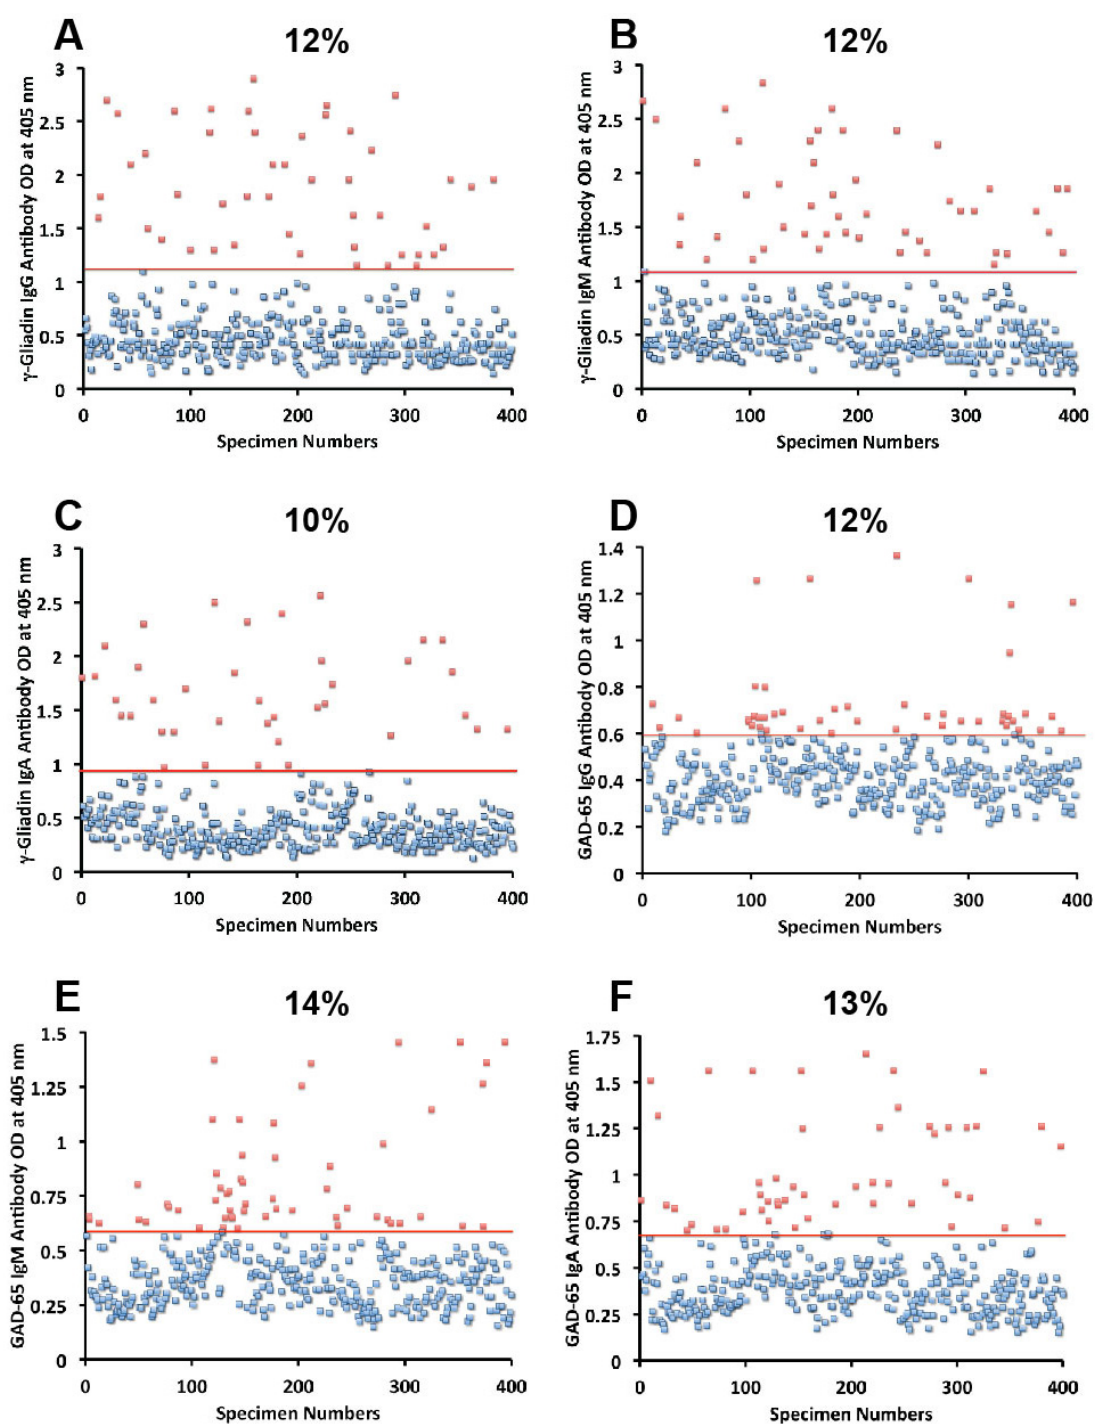
Figure 2. Results for γ -gliadin and GAD-65 expressed as OD at 405 nm in the form of scattergrams with percentages of elevation. ( A ) γ -gliadin IgG; ( B ) γ -gliadin IgM; ( C ) γ -gliadin IgA; ( D ) GAD-65 IgG; ( E ) GAD-65 IgM; ( F ) GAD-65